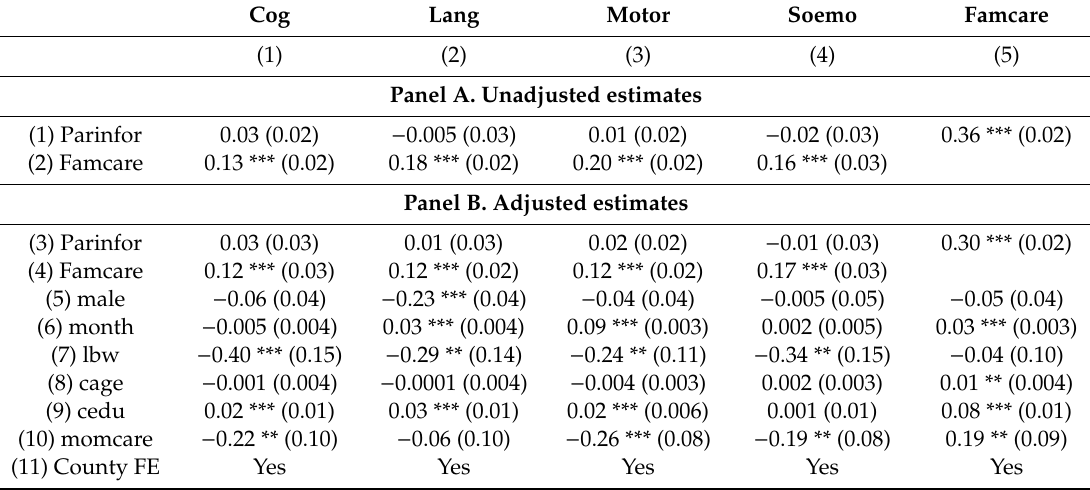
Table 2. SEM estimation of the mediation model ( N =